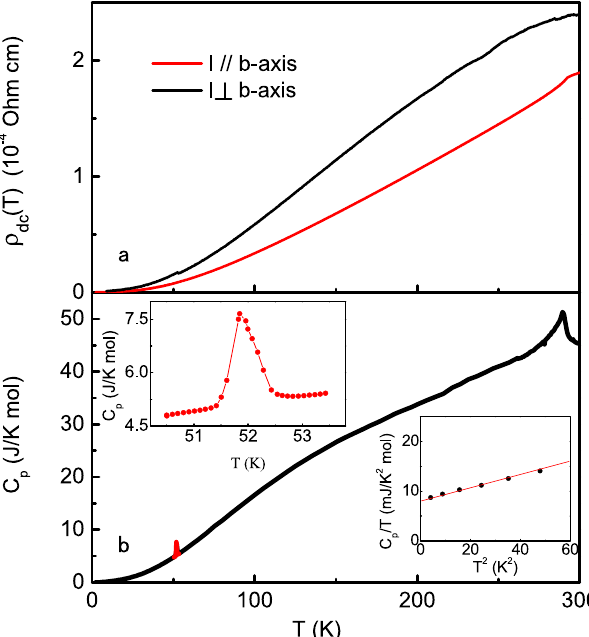
Figure 1. Resistivity and specific heat of MnP. ( a ) Temperature dependence of the dc resistivity ρ dc (T) along and perpendicular to the b -axis; ( b ) Temperature dependence of the specific heat C p ( T ), showing a para- ferromagnetic transition at about 290 K and a ferro-helimagnetic transition at about 51.8 K. The insets show the specific heat peak at the ferro-helimagnetic phase transition in the enlarged scale and the fit of C p ( T )/ T versus T 2 at low